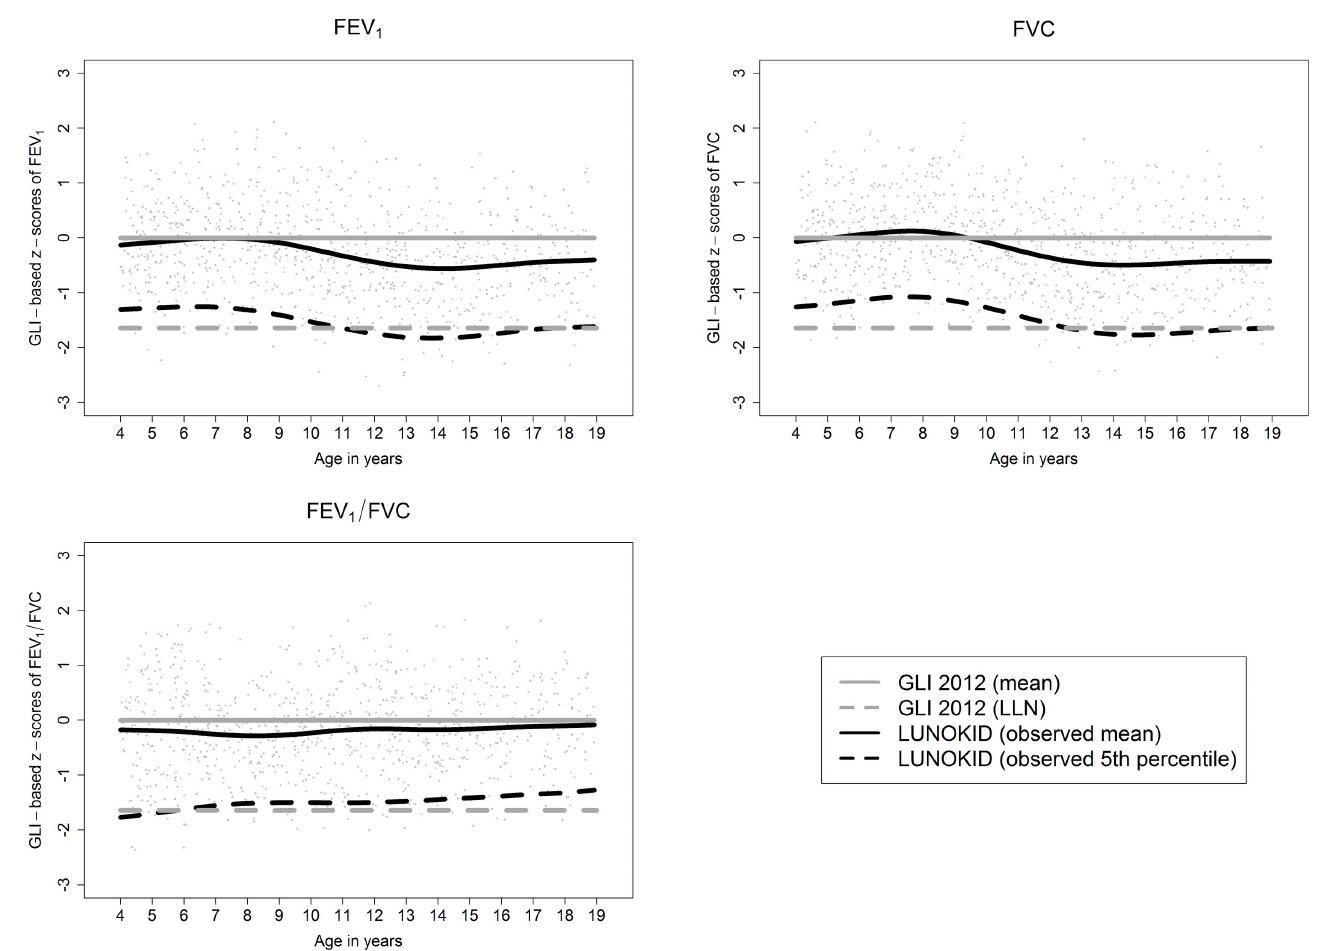
Fig 1. Comparison of the GLI-z-scores (mean and lower limit of normal (LLN)) with these observed in boys from the LUNOKID